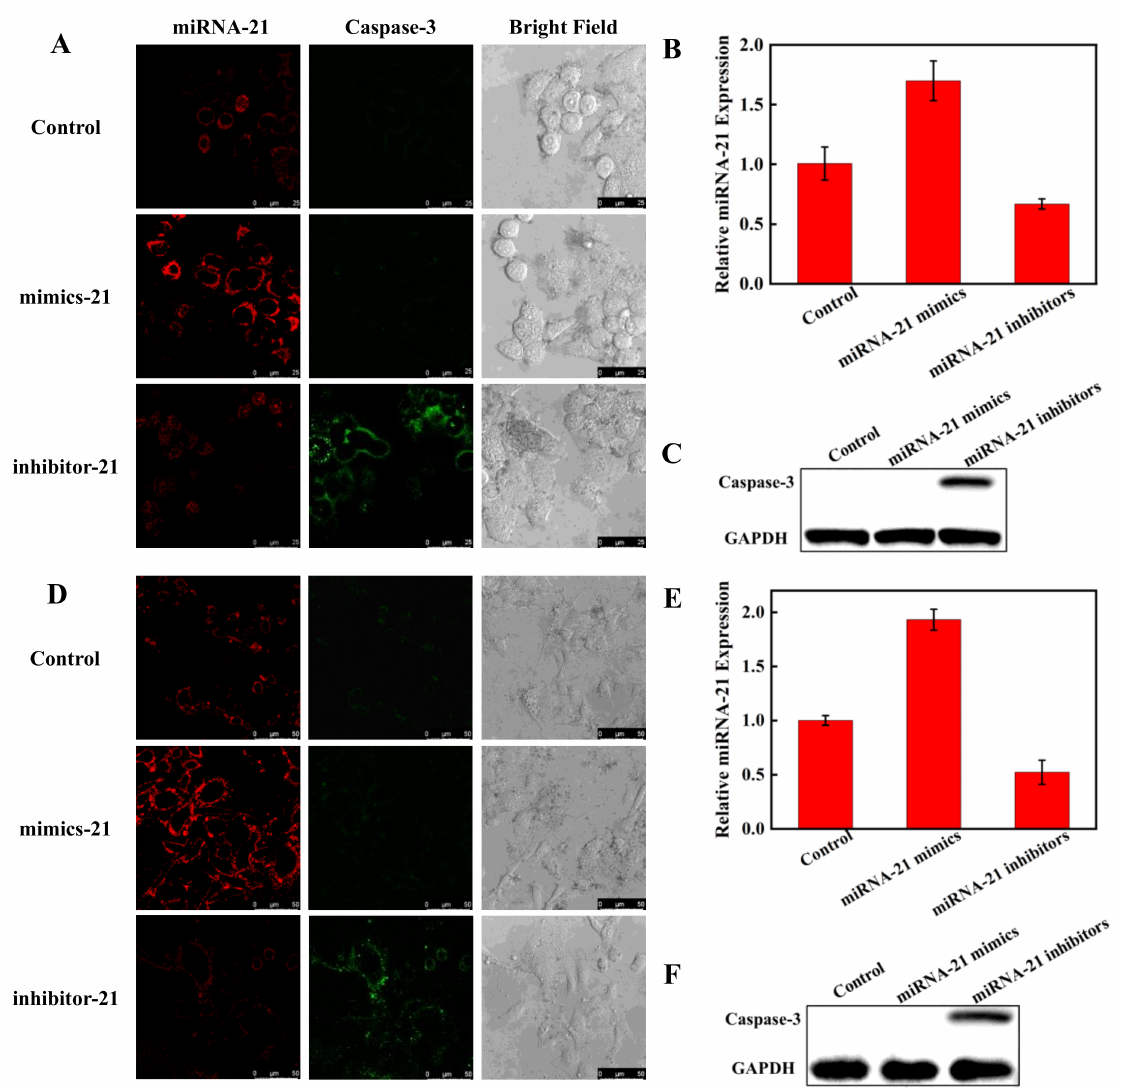
Figure 7. Visualizing miRNA regulation of apoptosis in Hela cells ( A ) by CLSM (scale bar: 25 µ m). Visualization of miRNA regulation of apoptosis in A549 cells ( D ) by CLSM (scale bar: 50 µ m). The cells were transfected with miRNA-21 mimics to increase miRNA-21 expression and transfected with miRNA-21 inhibitors to decrease miRNA-21 expression, respectively. Detection of miRNA-21 levels by RT-PCR in Hela cells ( B ) and A549 cells ( E ) after transfected with miRNA-21 mimics and miRNA-21 inhibitors. The Western blot assay of caspase-3 expression in Hela cells ( C ) and A549 cells ( F